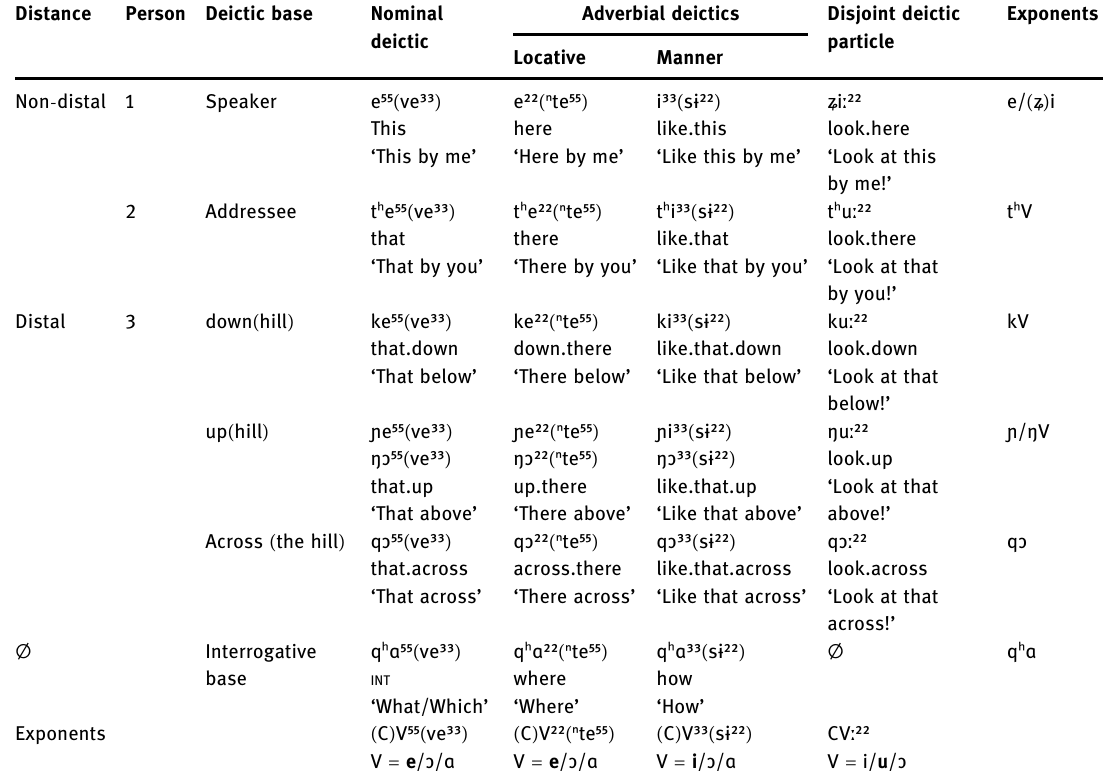
Table 1: The deictic - interrogative paradigm Distance Person Deictic base Nominal